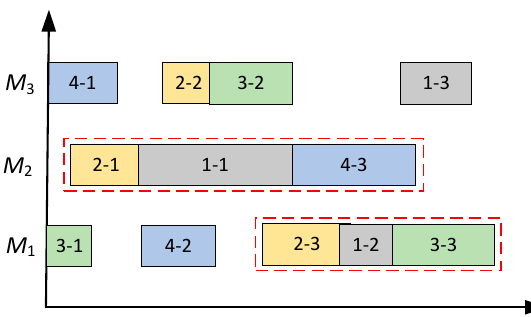
Figure 4. Resource configuration diagram of the earliest start time.